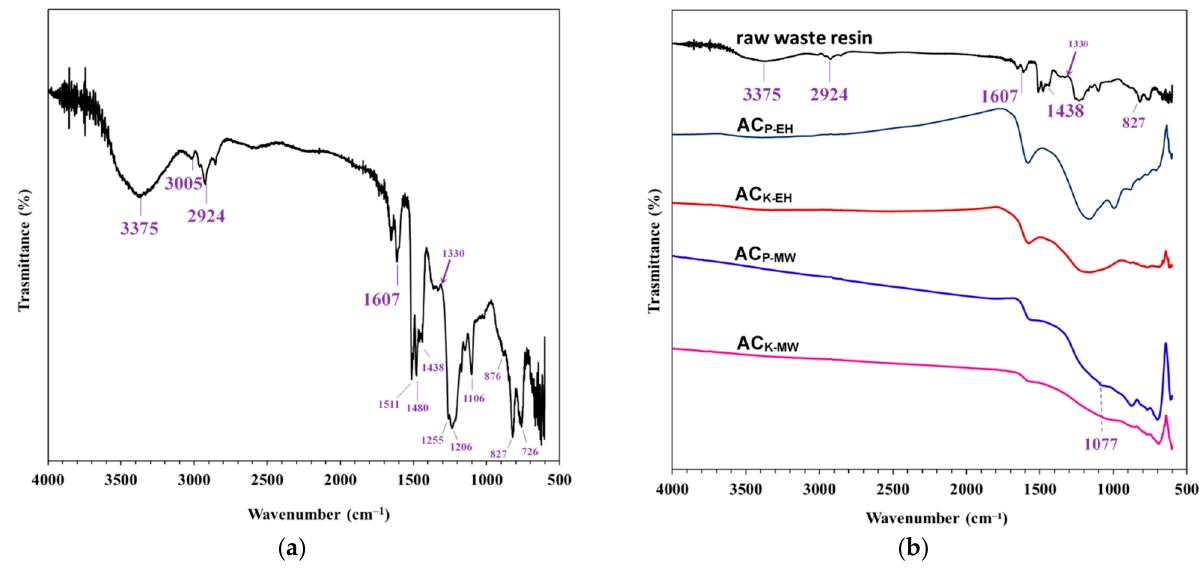
Figure 3. Fourier transform infrared spectra of ( a ) raw resin and ( b ) AC prepared under various conditions.